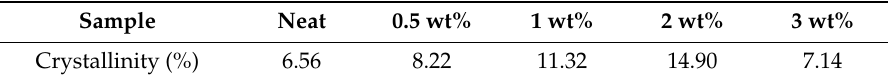
Table 2. The crystallinity of PEN nanocomposites with various h-BN@(PDA + PEI) contents.